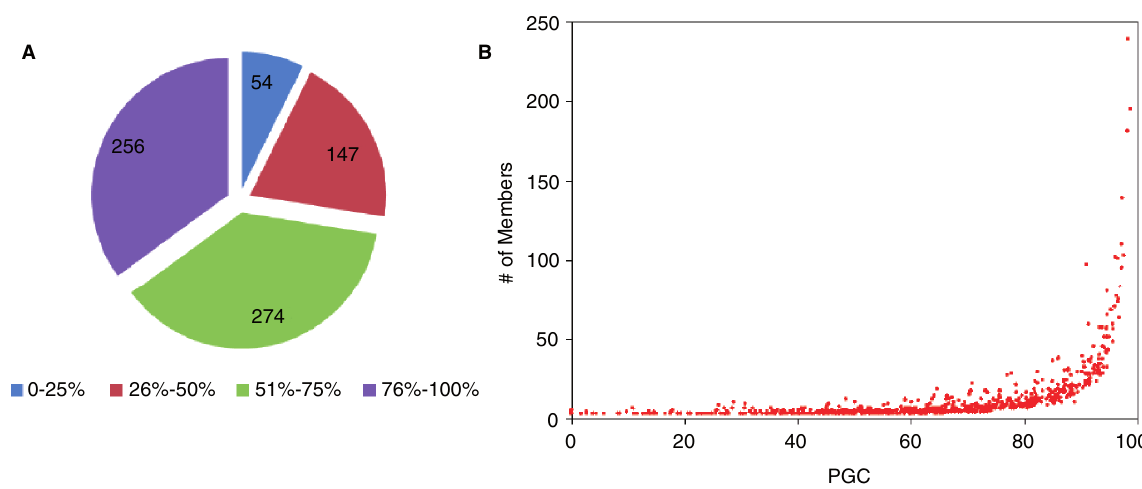
Figure 5. ( A ) Frequency of superfamilies based on PGC (Percentage Gain in Coverage) value divided into 4 bins (0–25%, 26–50%, 51–75%, 76–100%). ( B ) The PGC value plotted against number of members for all superfamilies.